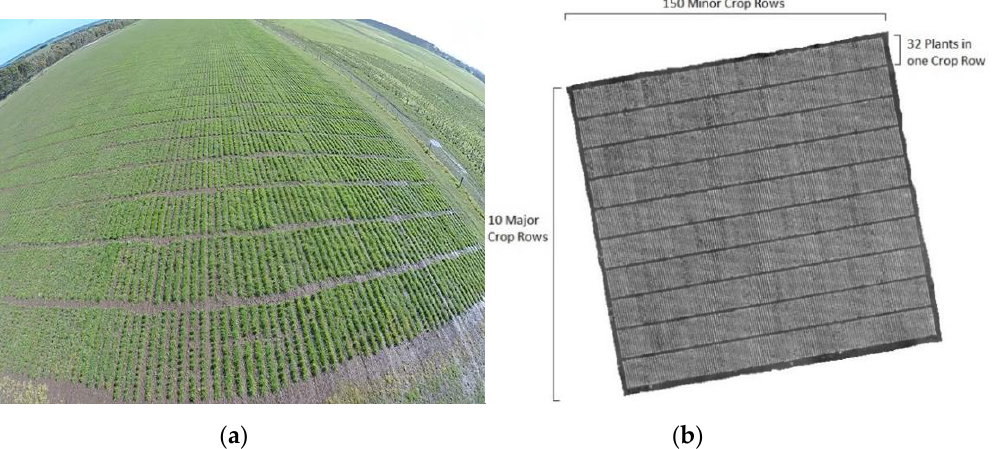
Figure 1. ( a ) An example of field trial in RGB form and ( b ) a grey scale image of the perennial ryegrass field trial stitched together from aerial images.